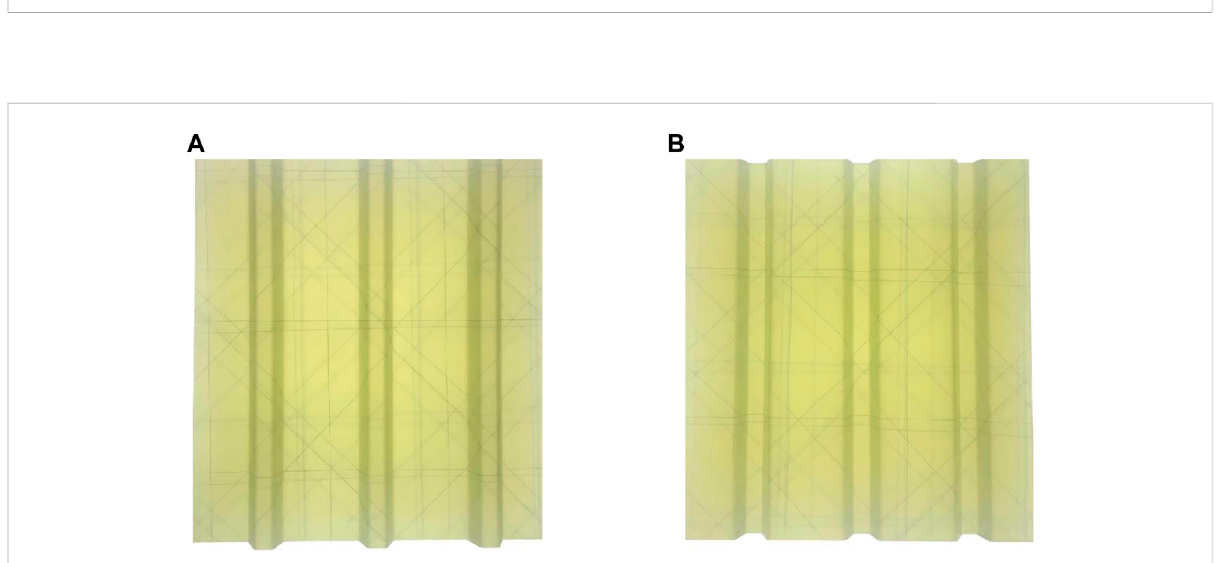
FIGURE 13 The translucent visual inspection of typical hat-shaped rib structure with the stacking sequence of [+45/0/-45/90] 2s (400 mm × 500 mm × 4.24 mm) (A) front; (B)